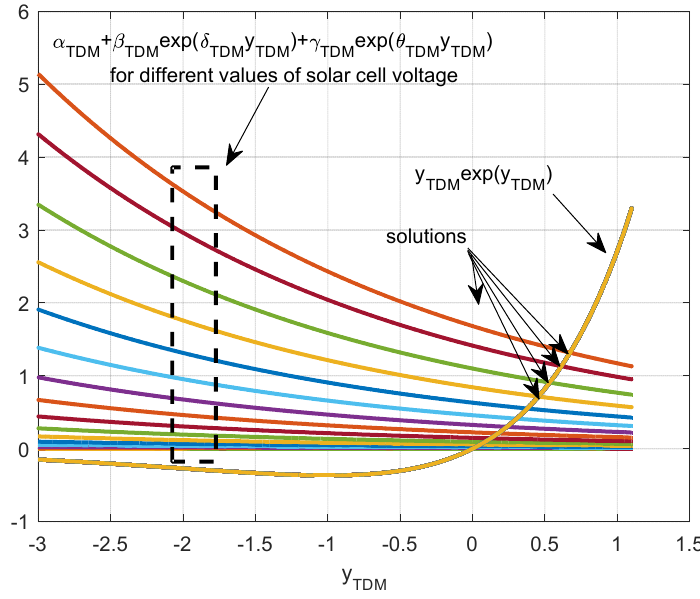
Figure 15. Visualization of α TDM + β TDM e δ TDM y TDM + γ TDM e σ TDM y TDM and y TDM e y TDM